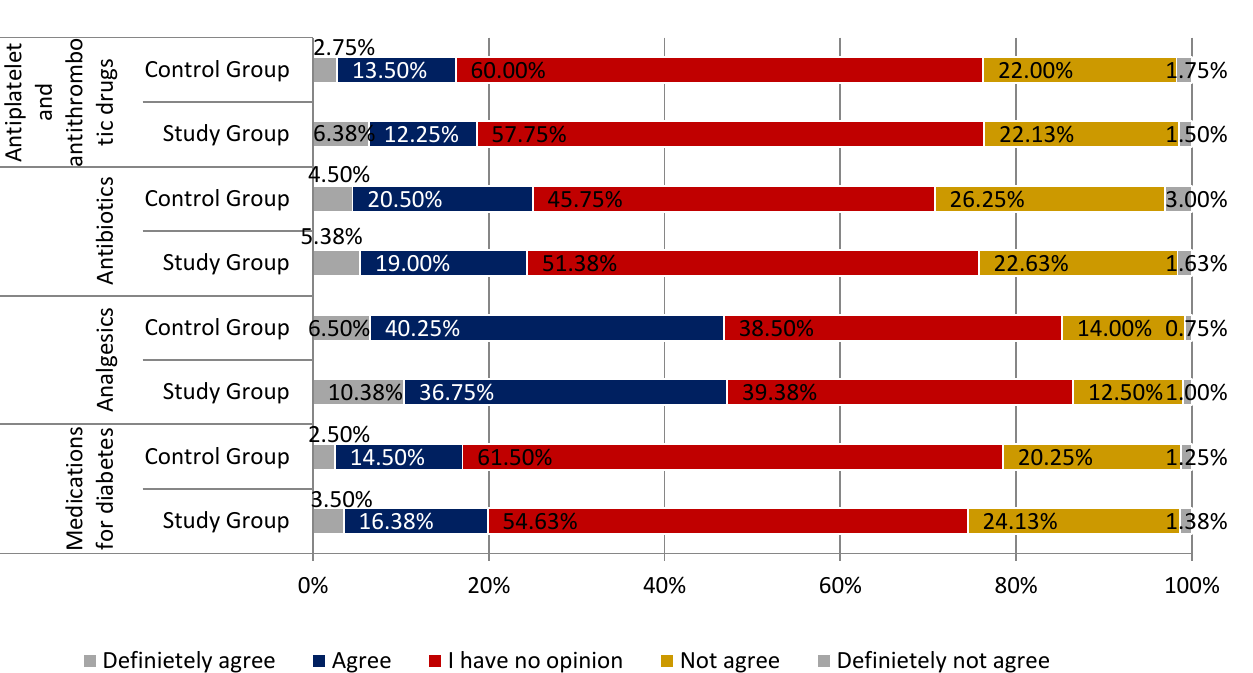
Figure 8. The most frequently falsified medicines in the opinion of respondents summary (part 1).